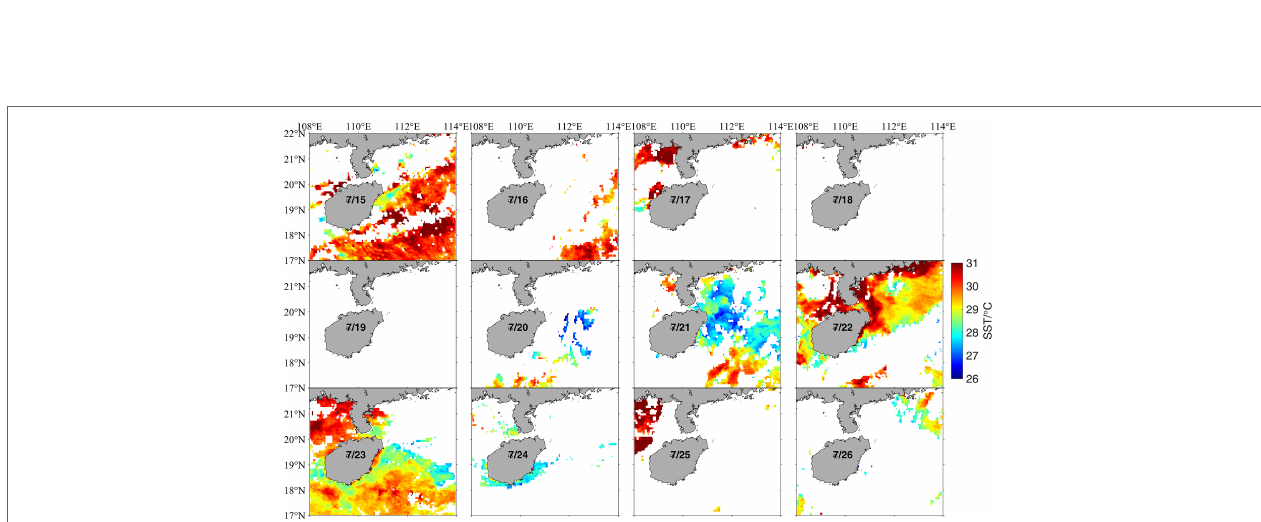
FIGURE 2 | Distribution of daily wind vectors and wind stress curl (×10 -6 Nm -3 ) from July 15 to 26.